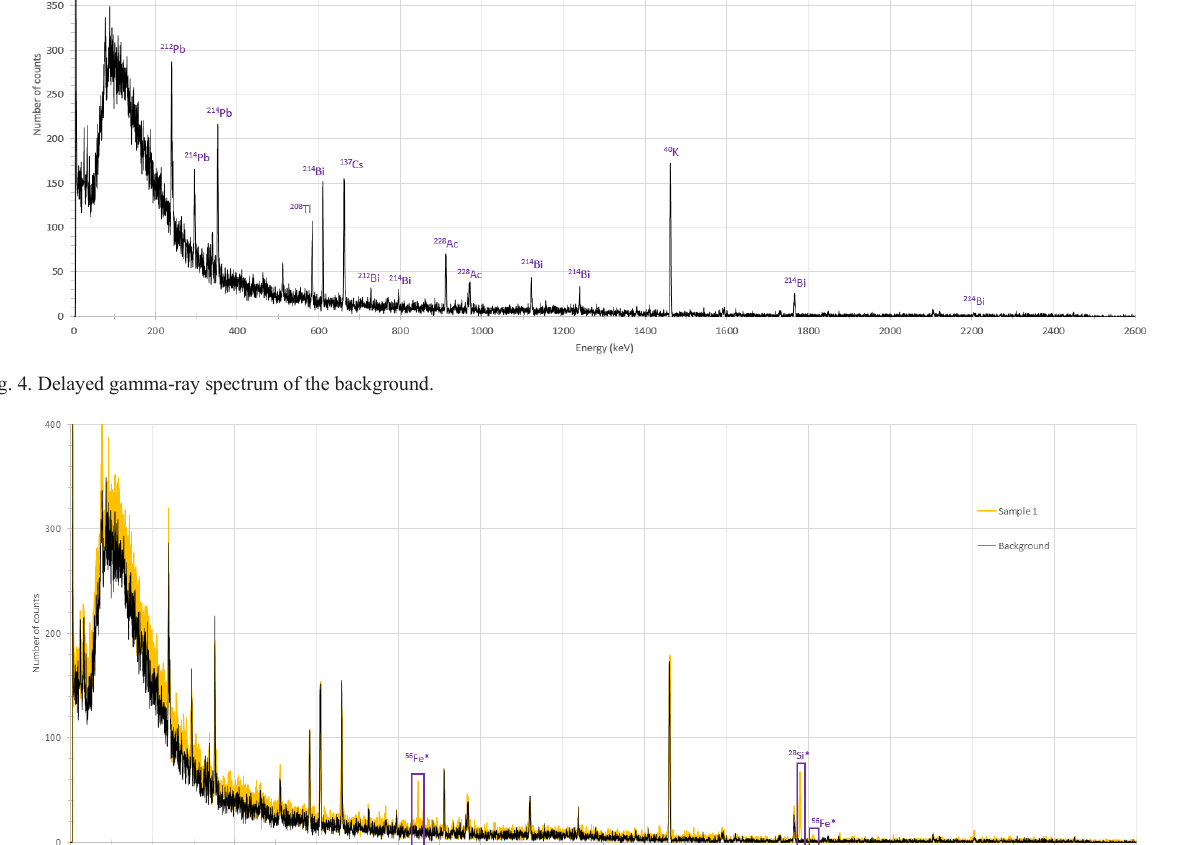
Fig. 5. Delayed gamma-ray spectrum of the sample No.